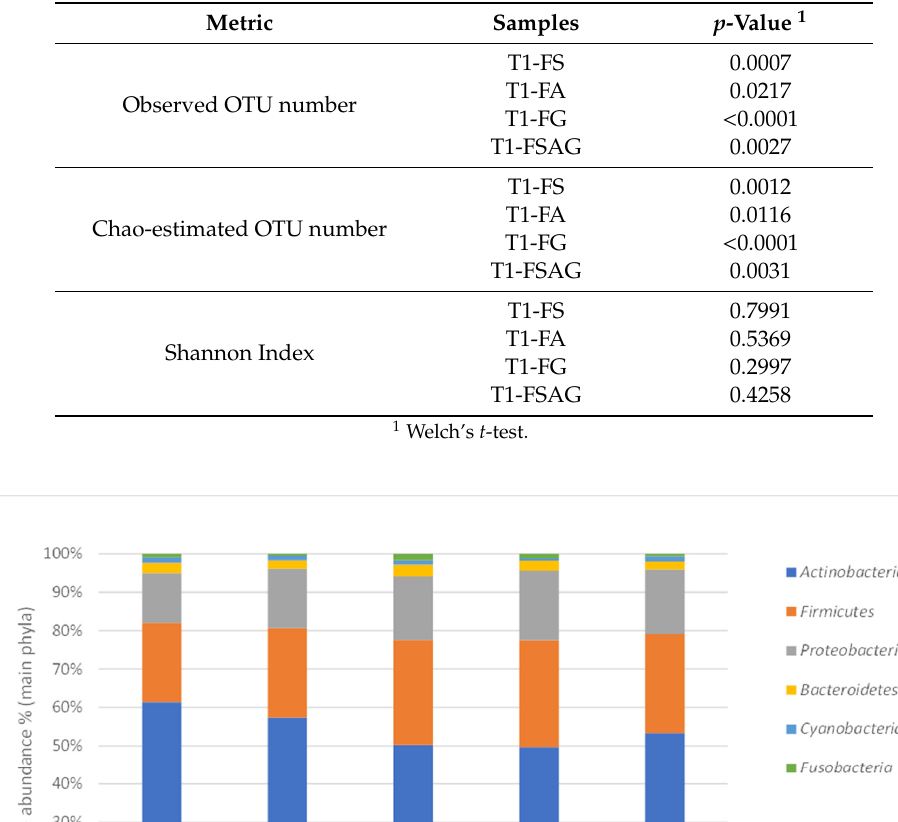
Table 2. Alpha diversity’s statistical significance.